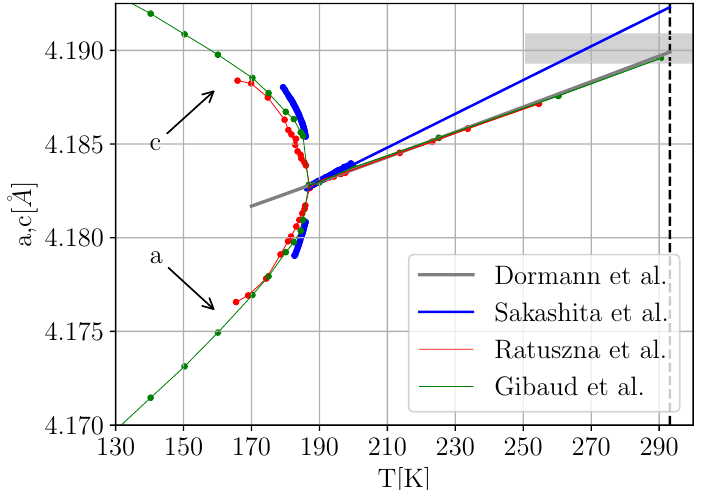
Figure 2. Collapse of data from Refs. [15] (red) and [18] (green), onto the low temperature expansion of the thermal expansion data of Ref. [14] (gray) by constant vertical shifts. The positive and negative branches of the data correspond to values (cid:101) t and (cid:101) a from the various references, respectively. As in Figure 1, the room temperature ambient pressure lattice constant of Ref. [11] is indicated by a horizontal gray bar for comparison. The shifted data from Ref. [16,17] (blue) clearly appear to be at odds with the other